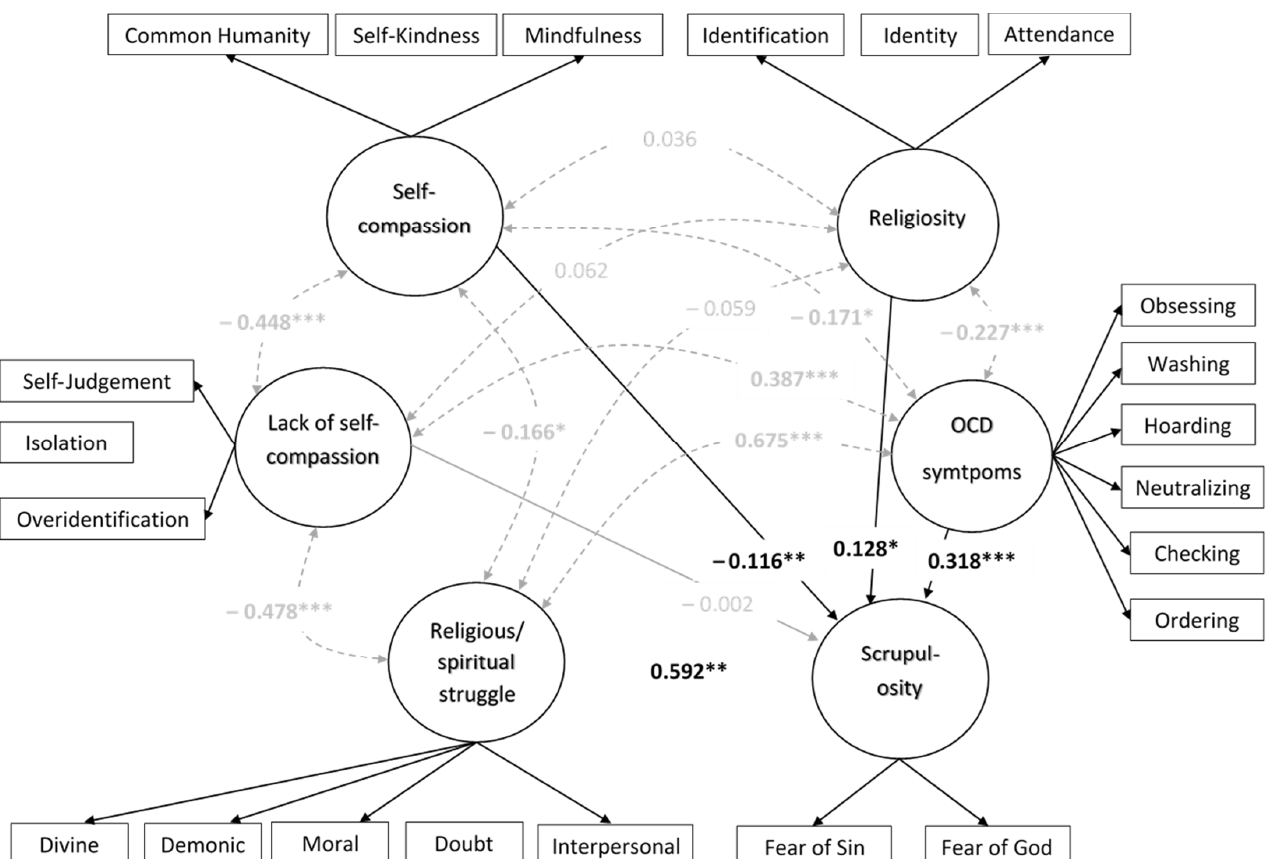
Figure 4. The structural model for the study variables (gray and dotted paths indicate covariations; bold coefficients were statistically significant; the coefficients are standardized; for the sake of clarity the loadings of observed variables on latent variables were omitted). * p < 0.05; ** p < 0.01; *** p < 0.001. The structural model explained 74.1% of the variance in Scrupulosity.